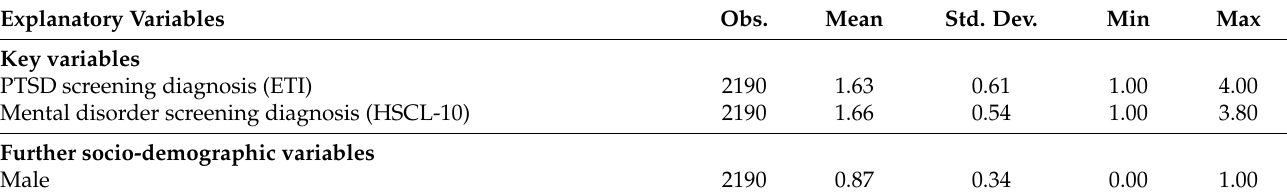
Table 3. Explanatory